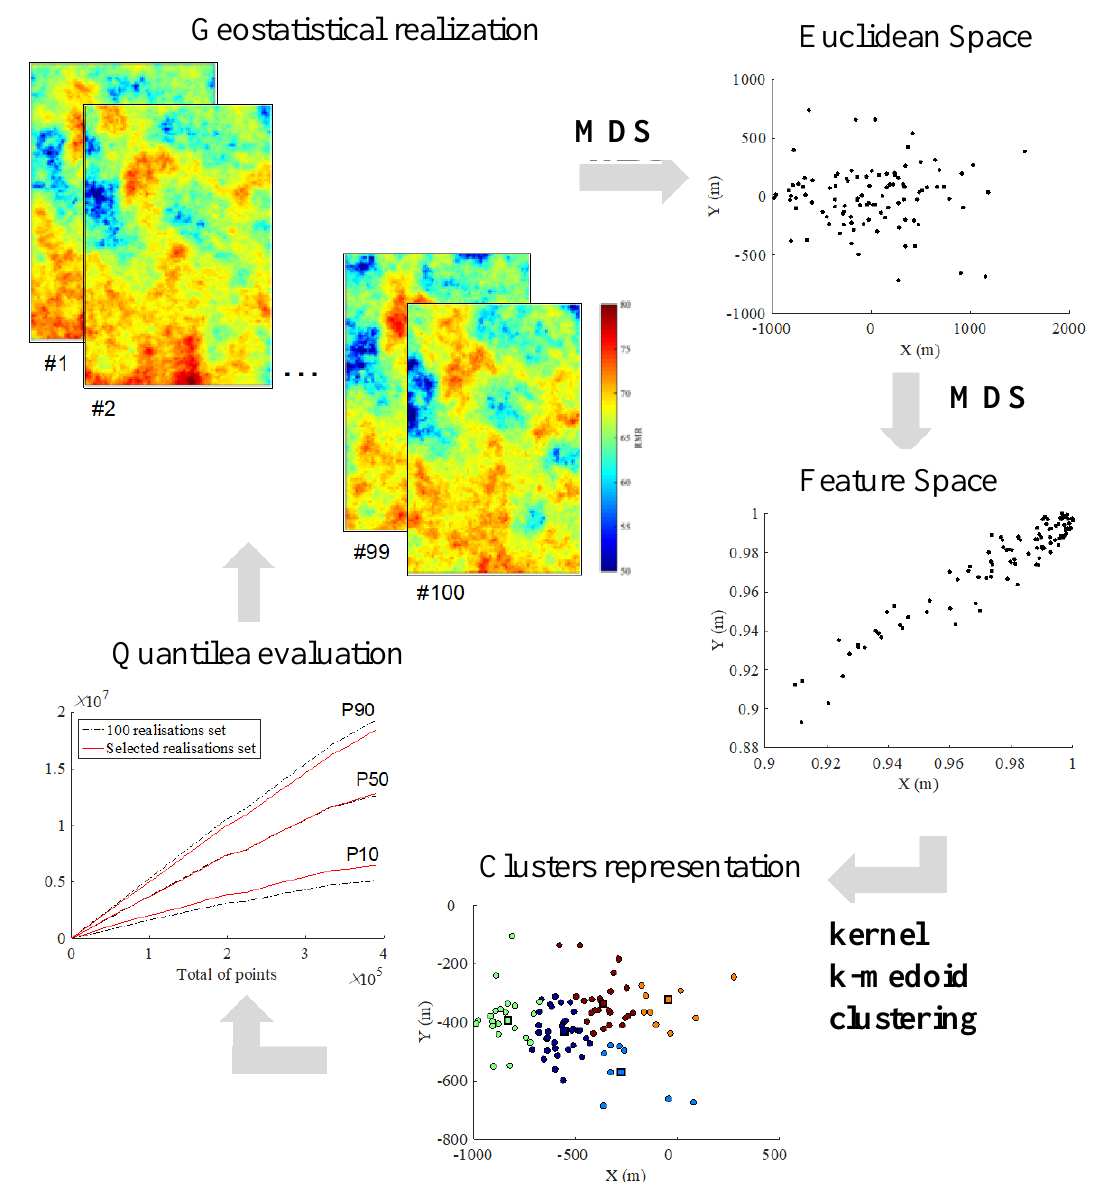
Figure 2. Scheme of the scenario reduction methodology. MDS: multi-dimensional scaling.